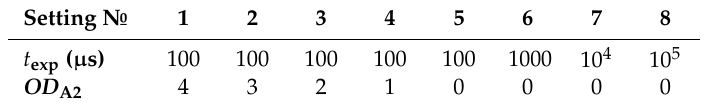
Table 4. Combinations of exposure time 𝑡 (cid:2915)(cid:2934)(cid:2926) and nominal optical density 𝑂𝐷 (cid:2885)(cid:2870) of attenuator A2.